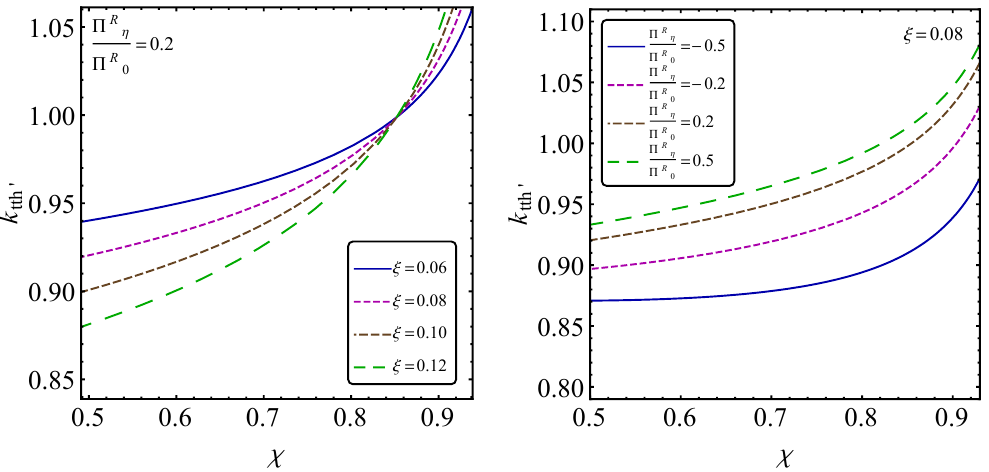
Figure 2. The variation of k with (cid:31) = h (cid:17) i 2 =f 2 is shown. In the left panel, for illustration, we tth 0 (see appendix C) (cid:12)xed at 0.2, and plot the curves for di(cid:11)erent values of (cid:24) . In keep the ratio (cid:5) R = (cid:5) R (cid:17) 0 the right panel we (cid:12)x (cid:24) and plot for di(cid:11)erent values of the ratio mentioned above. While